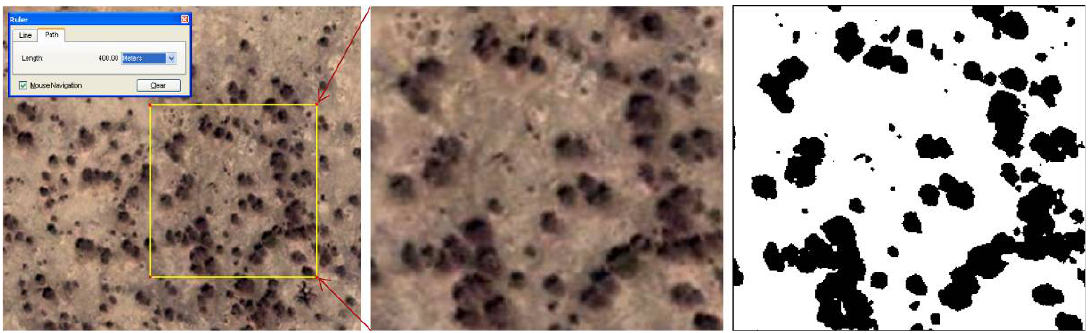
Figure 2. Measurement of canopy cover (CC) using the second approach (Left: 1 ha = 100 × 100m 2 plot No.262 in color; Middle: screen printed from Google Earth, copied and pasted into Photoshop and cut into the size of 100 × 100m 2 ; Right: black-and-white image with contrast enhancement between tree canopy (black) and soil background (white). CC = 19121 pixels/74528 pixels in total = 25.66%.